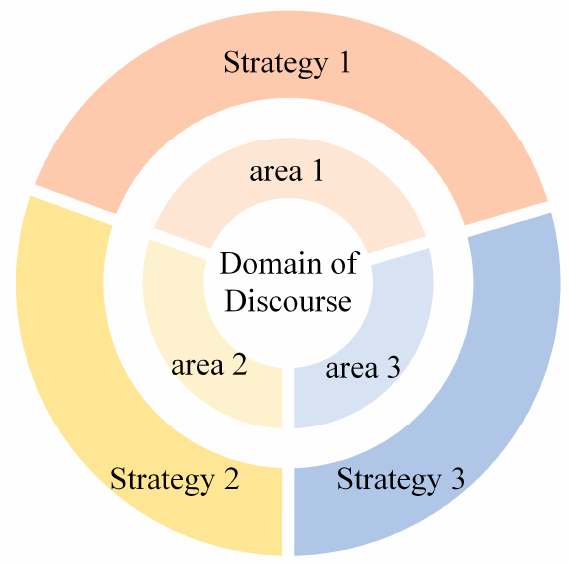
Figure 1. The idea of three-way decision.